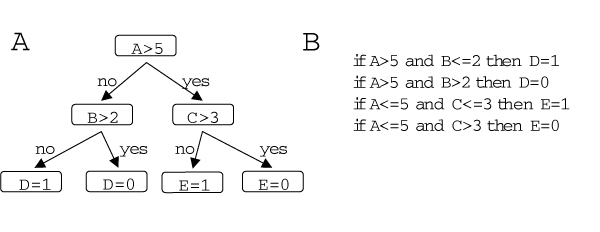
Decision trees. A decision tree is a special type of tree where the root and each interior node correspond to a variable; an arc to a child represents a possible value of that variable. A leaf represents the predicted value of target variable given the values of the variables represented by the path from the root. Following a route from the root node to a leaf node at each interior node we have to decide, which path to follow. Effectively each possible path encodes a decision rule. A Example for a decision tree. By following from the root node (top) to a leaf node (bottom) one has to make a decision at every interior node. B Corresponding set of decision rules.